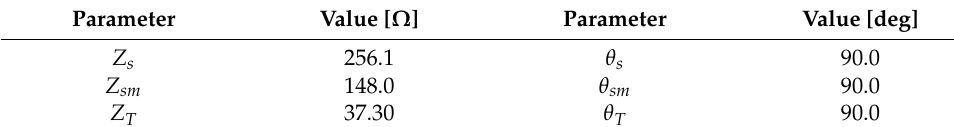
Figure 1. Conventional BPF with λ g /4 short stubs. Table 1. Calculated electrical parameters of conventional BPF.